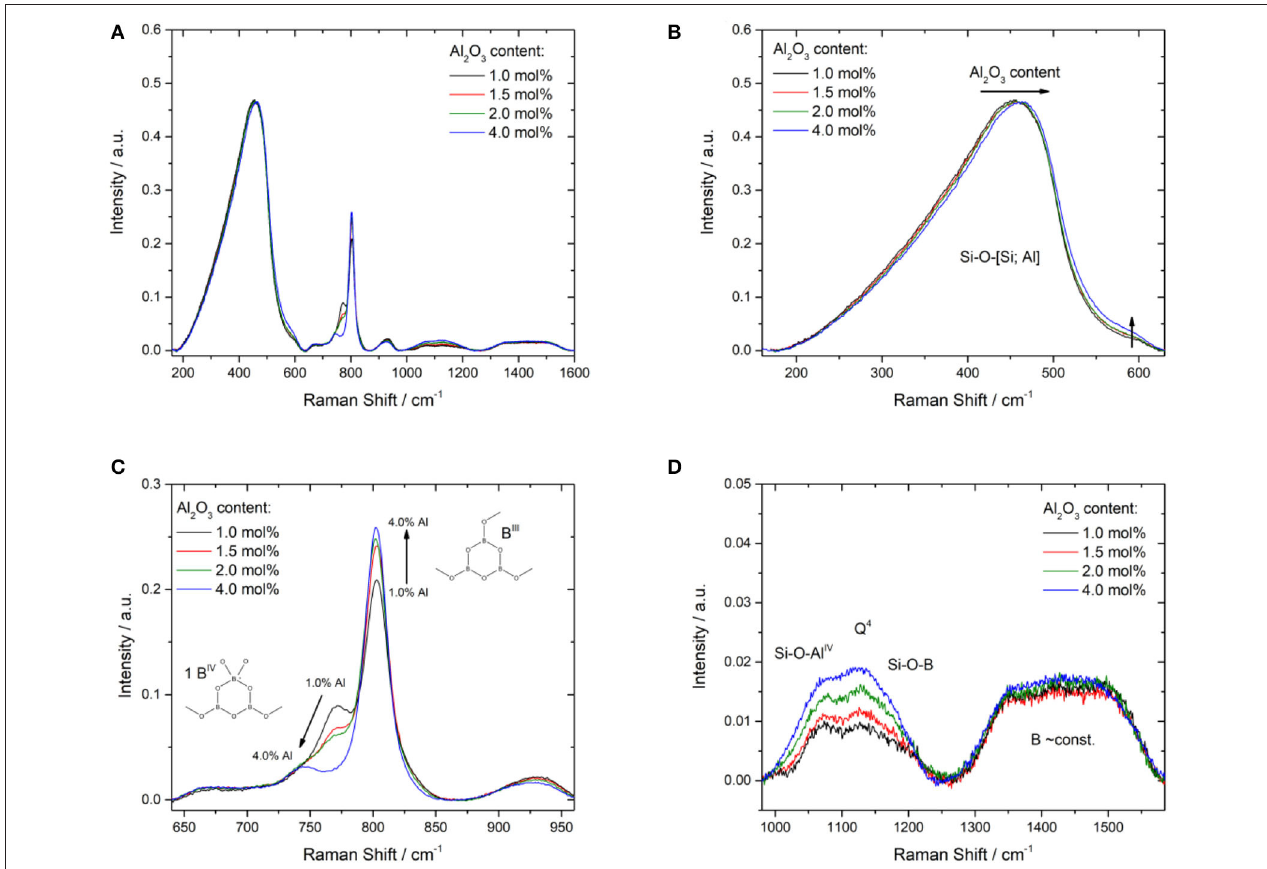
FIGURE 1 | (A) Area normalized Raman spectra of NBS2 glasses with changing Al 2 O 3 amount. Enlarged details show the silicate deformation modes (B) between 150 and 650 cm − 1 , the borate and boroxol ring modes (C) between 675 and 850 cm − 1 , and (D) stretching modes of borate tetrahedra at 920 cm − 1 , Si-O stretching modes between 950 and 1,250 cm − 1 , and of trigonal borate entities between 1,250 and 1,600 cm − 1